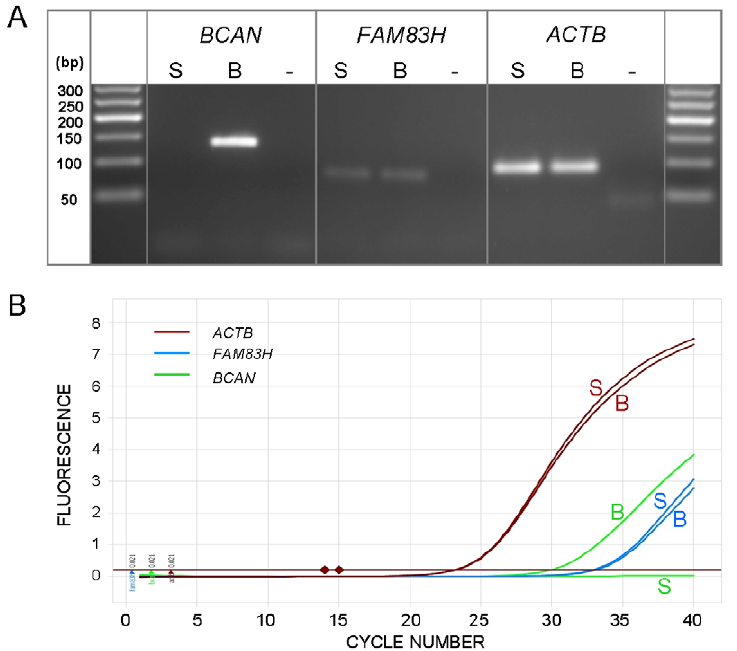
Figure 5. Expression levels of BCAN and FAM83H . Expression levels in brain (B) and skin (S) relative to the reference gene ACTB . PCRs were assessed at end point by agarose gel electrophoresis (A) and in real-time by qRT-PCR (B). Reactions performed in triplicate, but displayed as single curves for illustrative purposes.